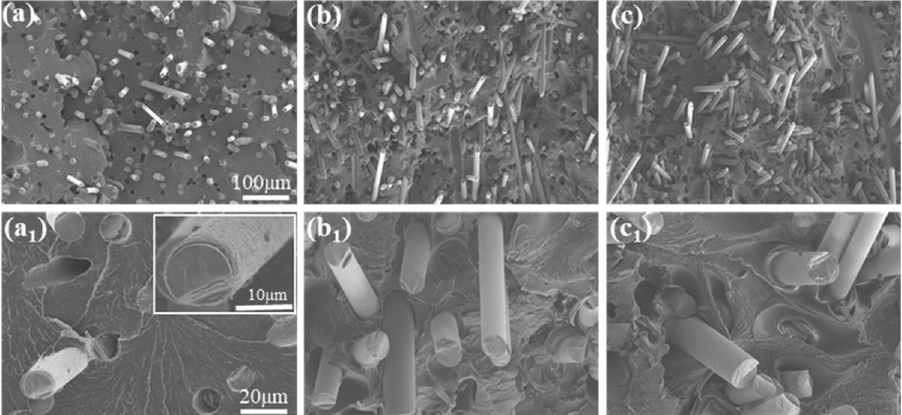
Fig. 9 SEM images illustrating the tensile-fractured surface of GF30-PPA samples. a Unaged sample, b 150 h-aged sample and c 700 h-aged